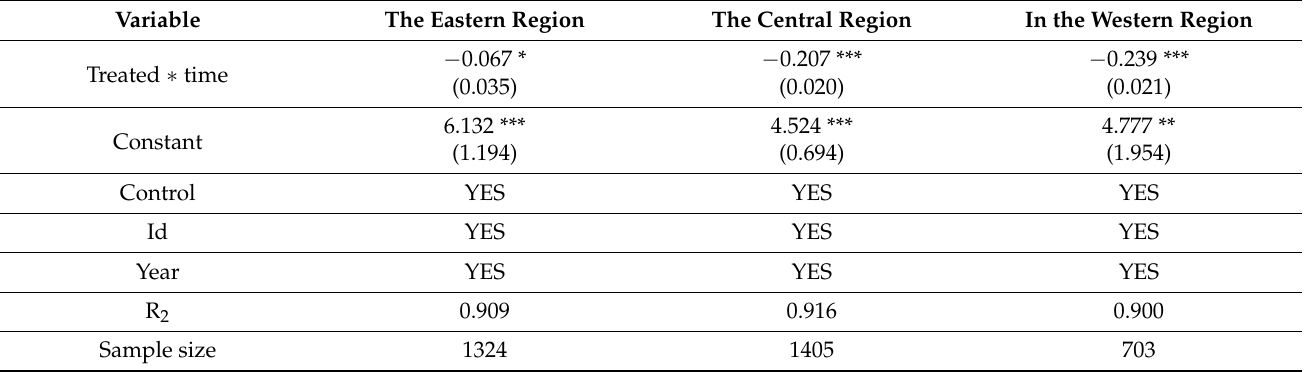
Table 5. Regional heterogeneity test.